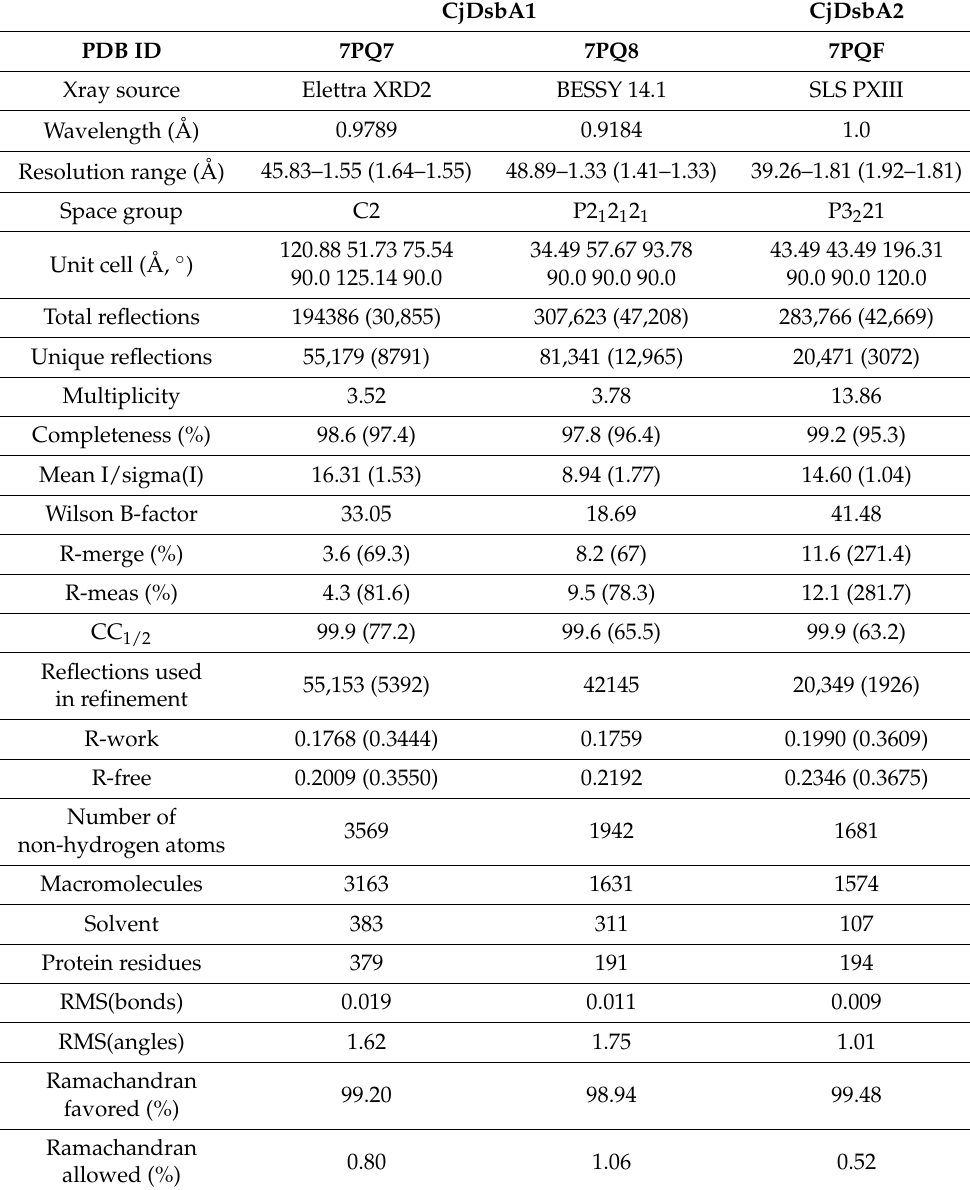
Table 6. Data collection and refinement statistics. Statistics for the highest-resolution shell are shown in